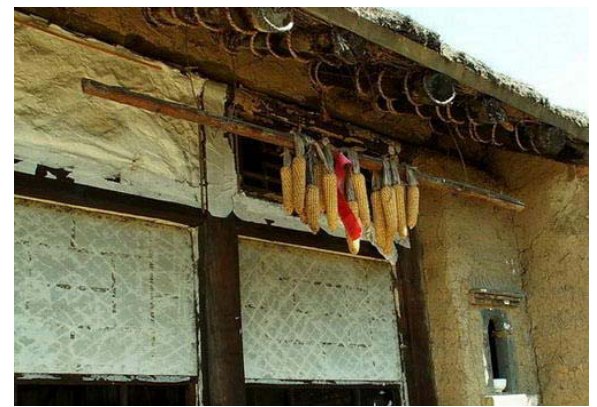
Figure 6. Outside image of a rice pulp window